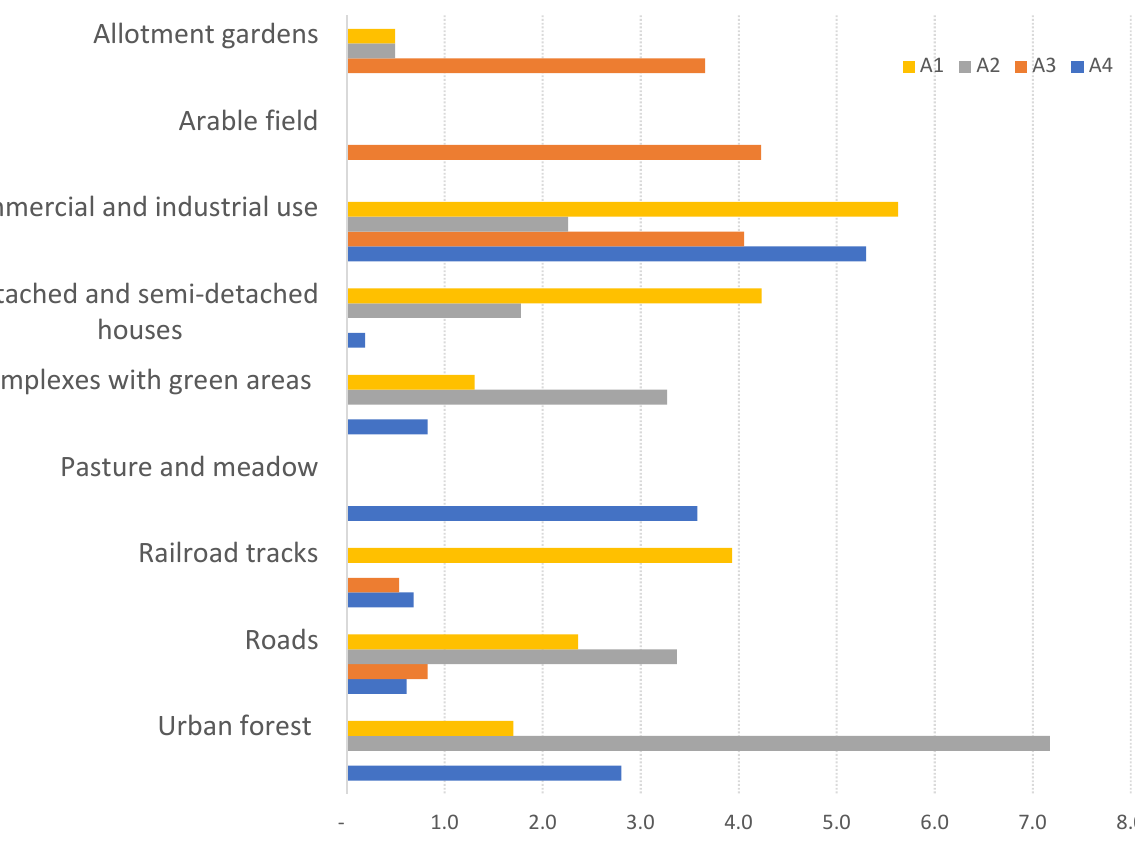
Figure 3. The USSs area lost from the development each of the access roads. Only the first three larger USSs in each alternative were plotted.